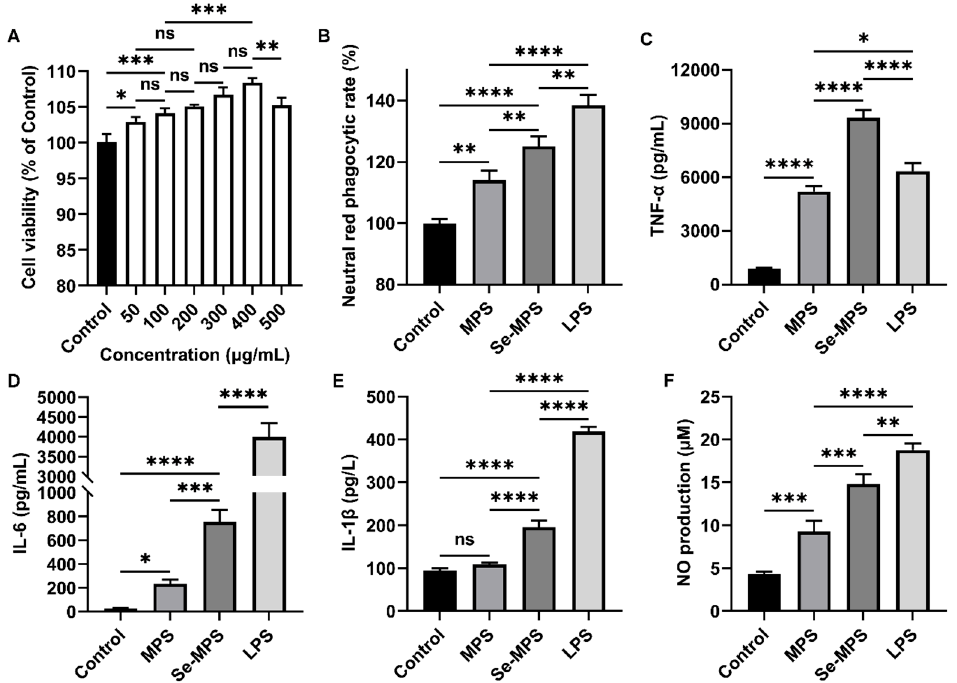
Figure 6. Cell viability of RAW 264.7 cells treated with Se-MPS ( A ), neutral red phagocytic rate ( B ), TNF- α ( C ), IL-6 ( D ), IL-1 β ( E ), and NO levels ( F ) of RAW 264.7 cells treated with MPS and Se-MPS. *, p < 0.05; **, p < 0.01, ***, p < 0.001; ****, p < 0.0001; ns, not signi fi cant; MPS— Morel polysaccharide;